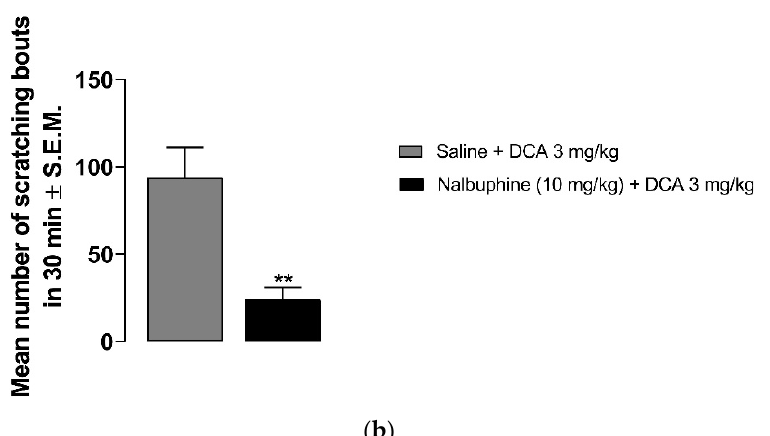
Figure 3. Nalbuphine inhibits DCA-induced scratching. DCA at 1, 3, and 10 mg/kg induces signifi- cant scratching compared to saline. Panel ( a ) (one-way ANOVA followed by Dunnett’s multiple comparison; * p < 0.05, *** p < 0.001; n = 7–8). Pretreatment with nalbuphine 10 mg/kg significantly reduces the number of scratching bouts in 30 min. Panel ( b ) (unpaired Student’s t -test; ** p < 0.01); n = 6). Swiss–Webster mice were used for these studies.